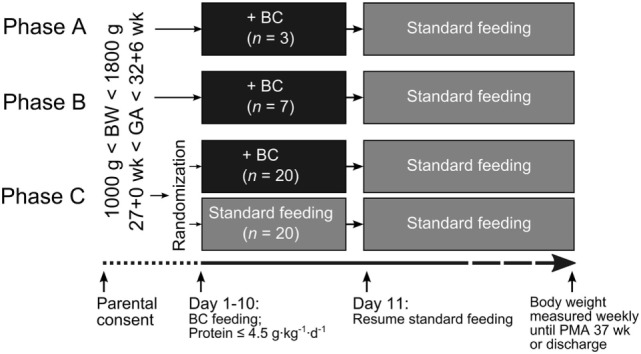
Design of the three-phased Precolos pilot study. BC is fed as the supplement (black boxes) when mother’s own milk is insufficient, instead of feeding donor milk (RH and HH) or infant formula (FWCH and SBMCH), according to local guidelines. In phase A, BC was given to three infants consecutively, i.e., each infant was followed until it reached full enteral feeding, and weight gain was 15 g·day−1 before the next infant was included. In phase B, BC was given to seven infants recruited in parallel. Phase C will be a randomized controlled trial (not yet completed). Due to differences in the normal progression of enteral feeding among hospitals, the BC intervention period was up to postnatal day 10 at RH and HH and will be up to postnatal day 14 for FWCH and SBMCH in phase C. BC, bovine colostrum; BW, birth weight; FWCH, Foshan Women’s and Children’s Hospital; GA, gestational age; HH, Hvidovre Hospital; PMA, postmenstrual age; RH, Rigshospitalet; SBMCH, Shenzhen Baoan Maternity and Child Healthcare Hospital.